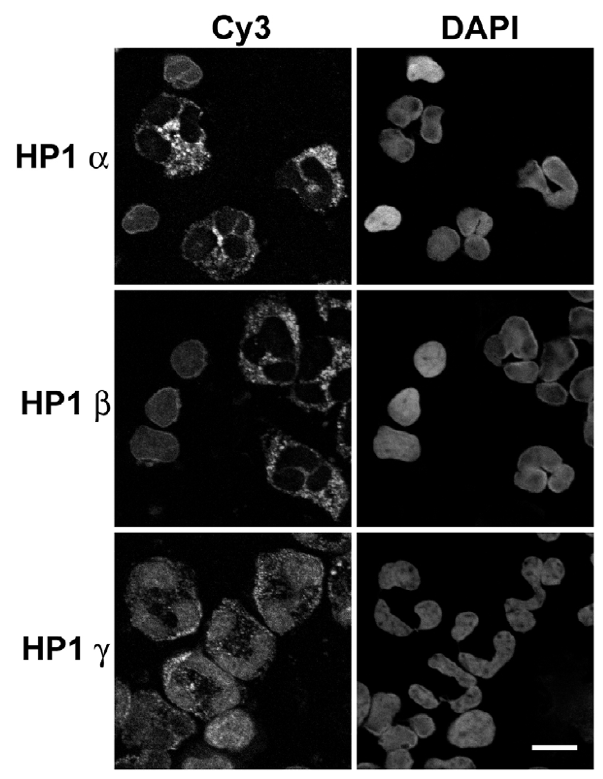
granules. Scale bar: 10 µ